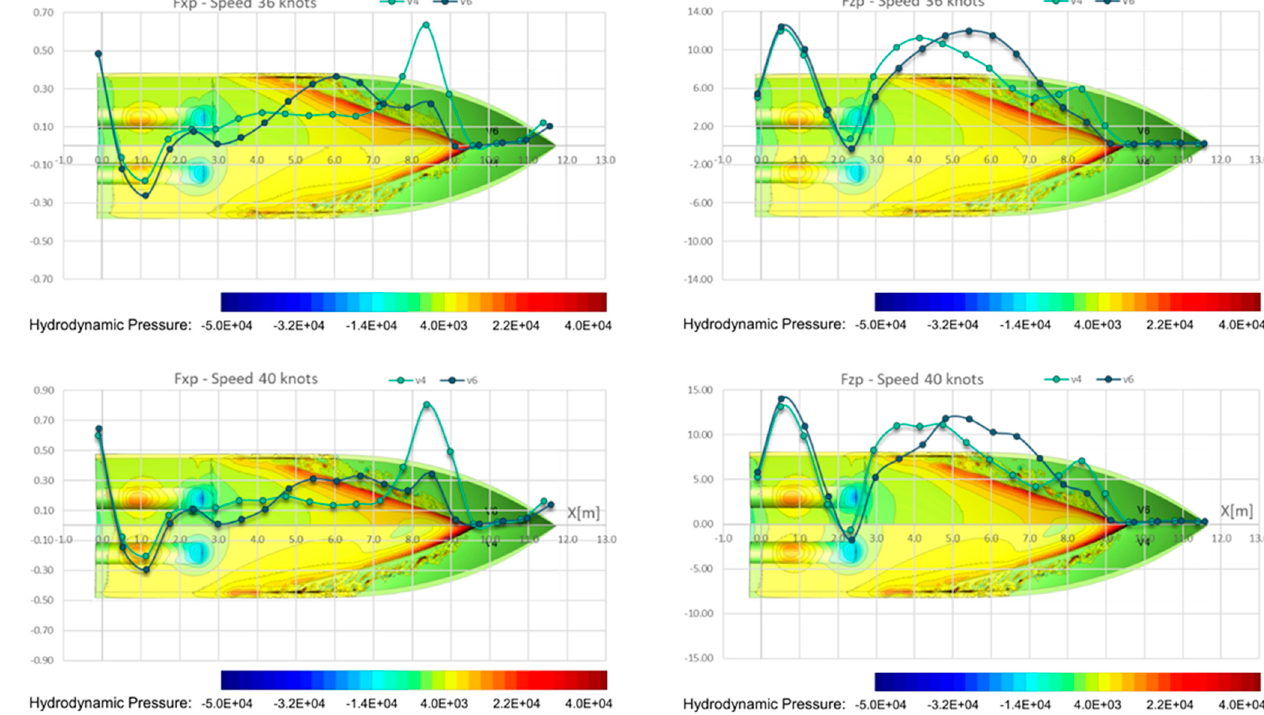
Figure 12. Forces and pressure distributions comparison for V4 and V6, at 36 and 40 kn.